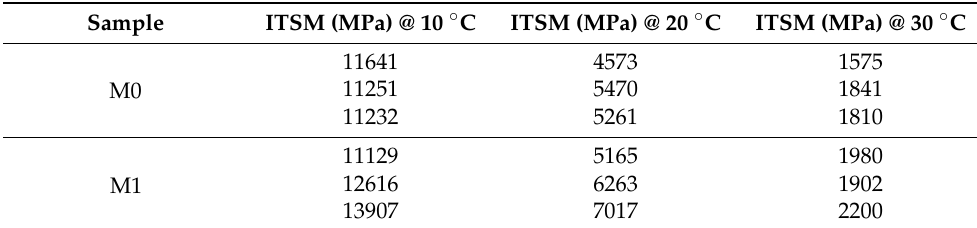
Table 9. Average results of ITSM test at 10, 20 and 30 ◦ C for